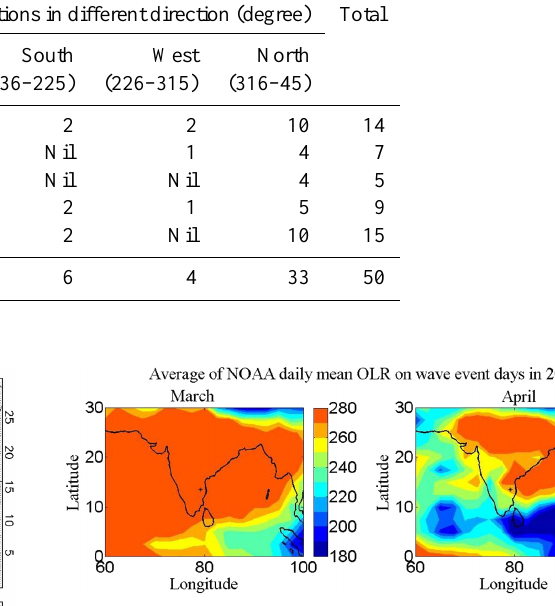
Figure 7. The average of daily mean OLR for the days when waves were observed in airglow image data in March and April 2012. The location of measurements is shown as an